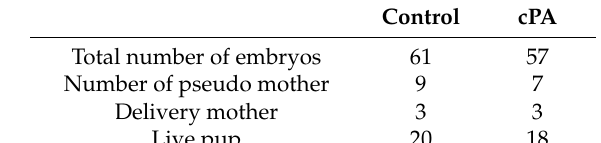
Table 1. Live birth results for cyclic phosphatidic acid (cPA)-treated ovaries used for embryo transfer into recipient mice.